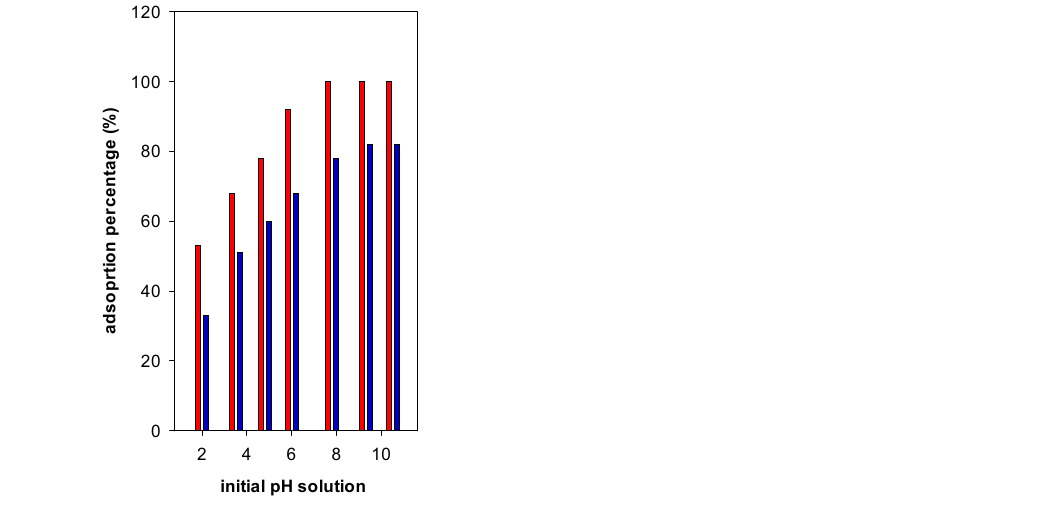
Figure 8. Effect of basic Blue -41 pH solution on the adsorption percentage (%) using Zr(6)-PCH (red bar) and Zr(12)-PCH (blue part) materials.